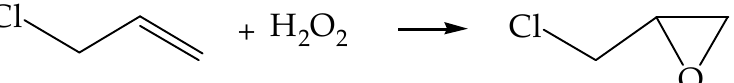
Figure 8. Reaction mechanism of epichlorohydrin synthesis from allylchloride. Table 4. Summary of catalyst systems for one-step synthesis of epichlorohydrin.